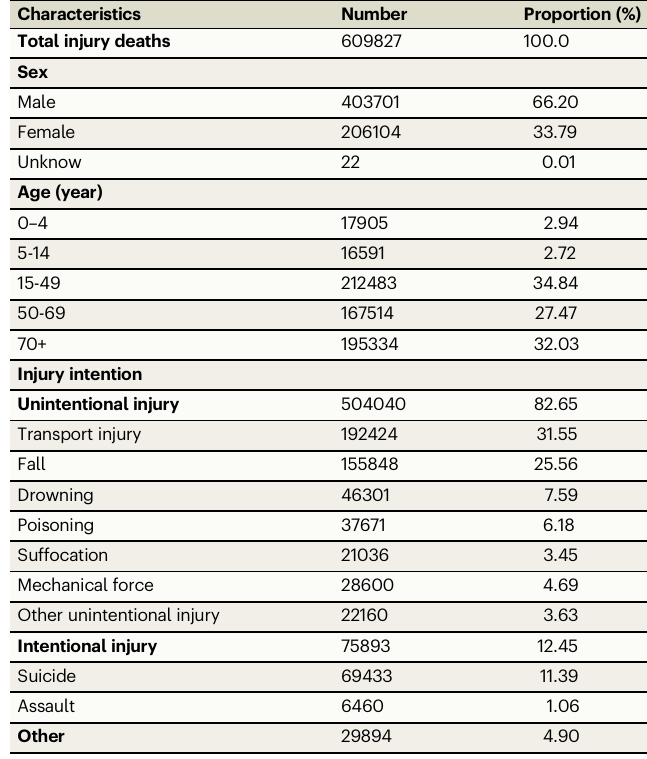
Table 1 | The basic characteristics of injury deaths in six provinces, China